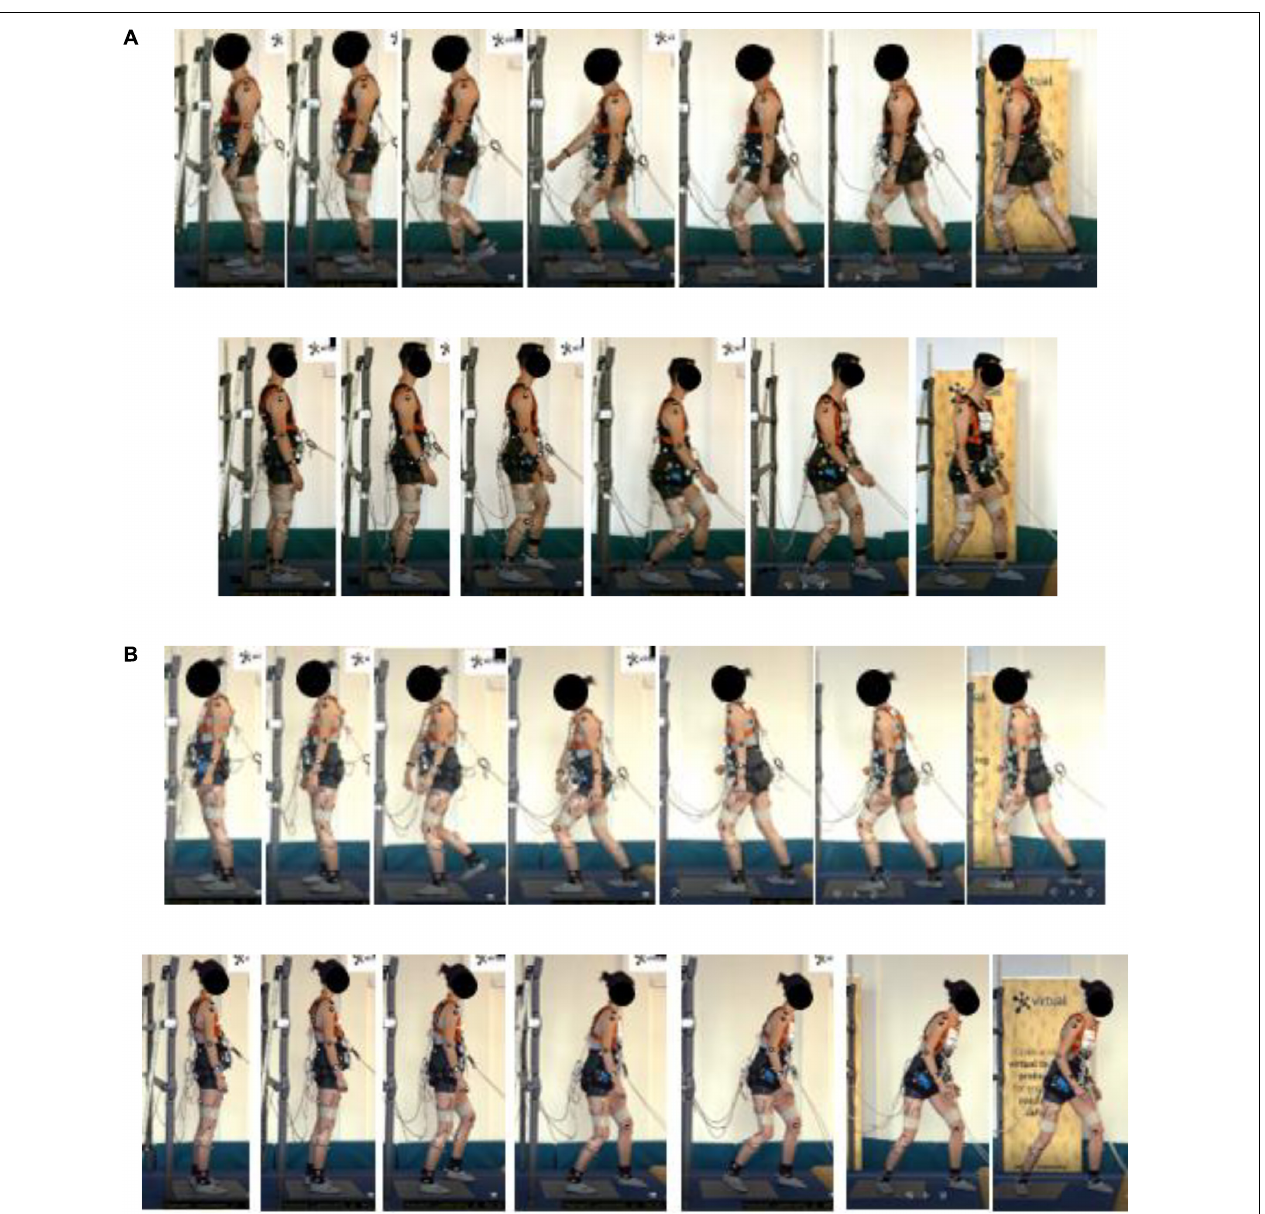
Table 5 . Volunteers with higher failure rates to